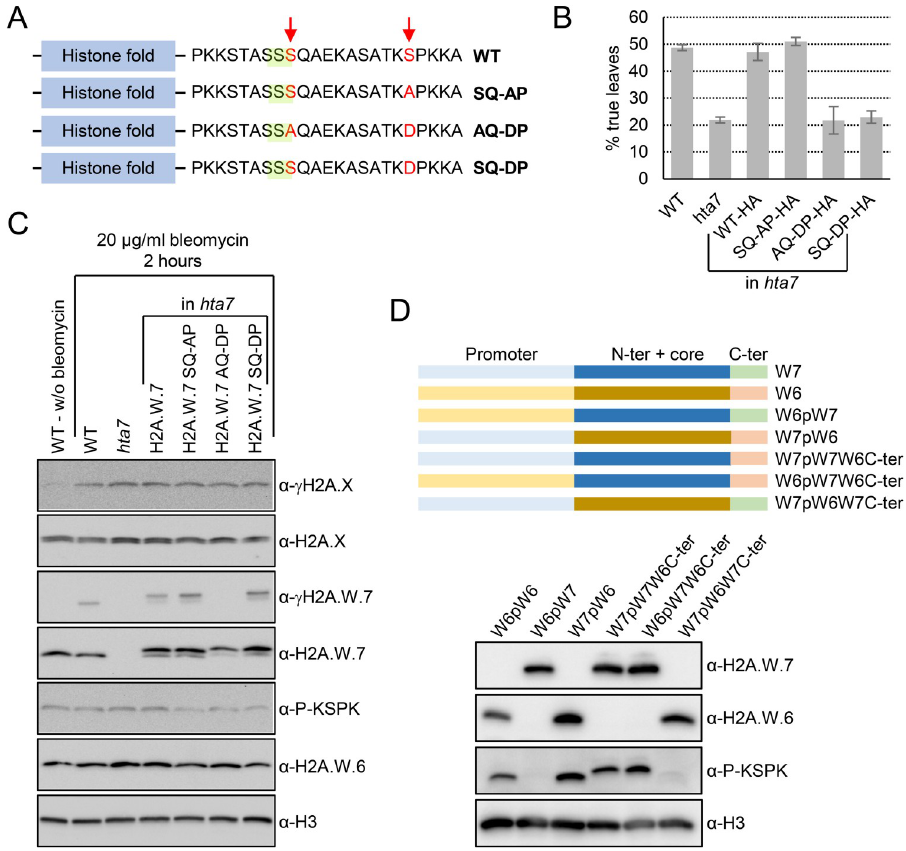
Fig 4. Phosphomimic of KSPK phosphorylation results in DNA damage sensitivity in planta . (A) Schematic diagrams of Arabidopsis H2A.W.7 variants containing mutated serin residues (in red) in the SQ (highlighted in green) and KSPK motifs. (B) Phosphomimic of the KSPK motif confers DNA damage sensitivity. Seeds from h2a . w . 7 mutants expressing HA-tagged WT H2A.W.7 or H2A.W.7 with mutations in the SQ and KSPK motifs were germinated in the presence of 50 mg/mL of zeocin and scored for true leaf development twelve days after germination. Data are represented as means ± SD of three independent experiments with n > 400 seedlings. (C) Phosphomimic of the KSPK motif does not prevent SQ motif phosphorylation of H2A.W.7. Seedlings grown for 10 days on MS plates were treated for two hours with 20 μ g/ml of bleomycin and nuclear extracts were analyzed by western blotting with the indicated antibodies. (D) Primary sequence of the H2A.W C-terminal tail determines phosphorylation outcome of the KSPK motif. Schemes of promoter, histone core domain and C-terminal tail swaps between H2A.W.6 and H2A.W.7 (top panel). Western blot analysis of expression and KSPK motif phosphorylation of nuclear extracts from plants expressing indicated H2A.W swap versions in mutant plants deprived from H2A.W (bottom panel).